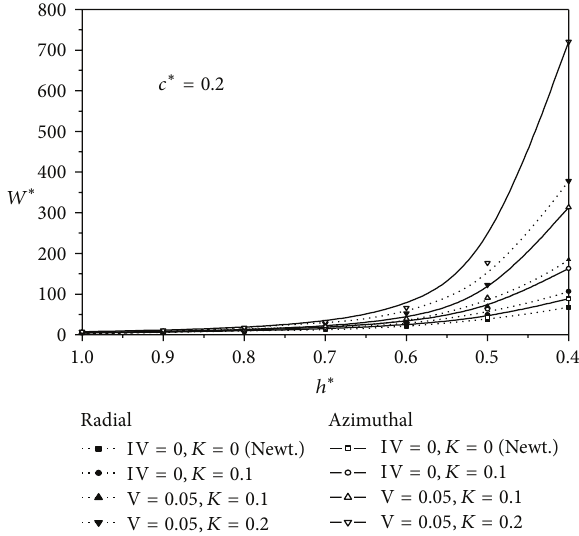
Figure 4: Load capacity 𝑤 ∗ versus the film thickness ℎ ∗ for different 𝑉 and 𝐾